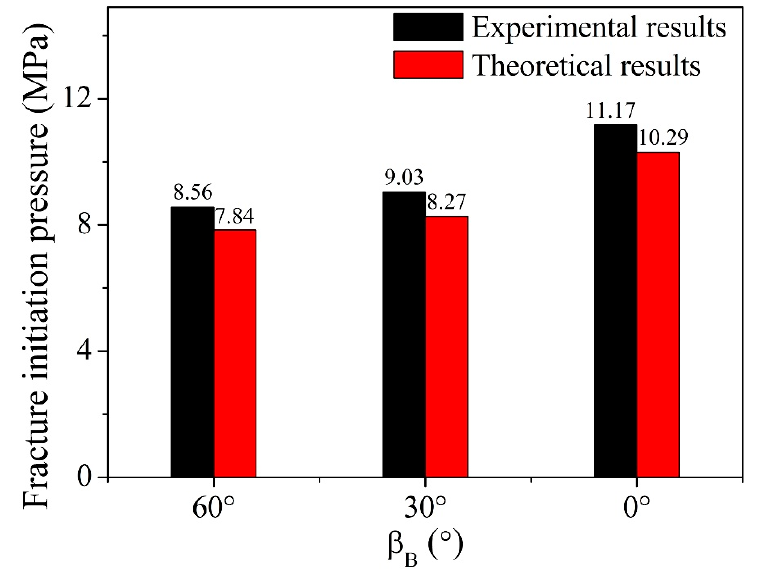
Figure 13. The comparison between experimental and theoretical results.